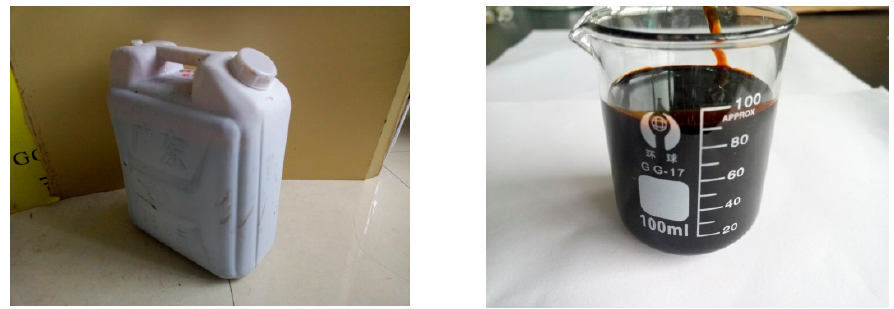
Figure 1. The sugar beet molasses (SBM) of Xinjiang Green Xiang Sugar Industry Co., Ltd., Tacheng, China.